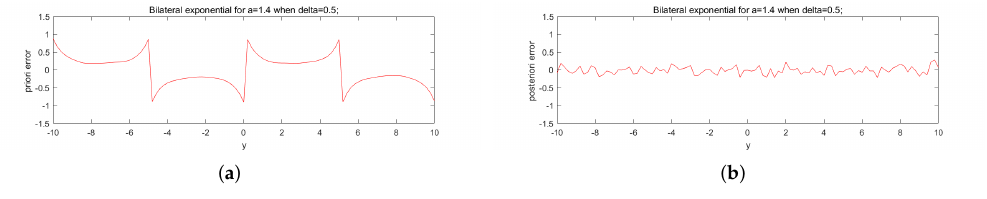
Figure 4. ( a ) priori error. ( b ) posteriori error. The errors of a ( x ) when δ = 0.5, α = 1.4.